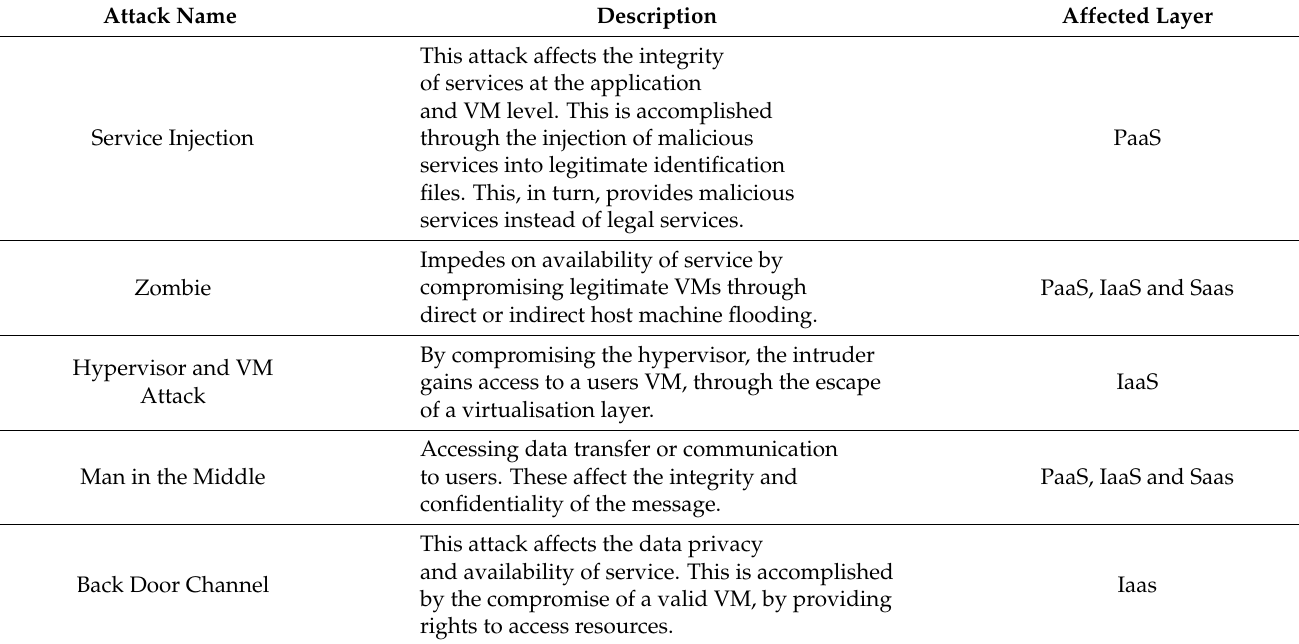
Table 9. Intrusion detection security threats to cloud